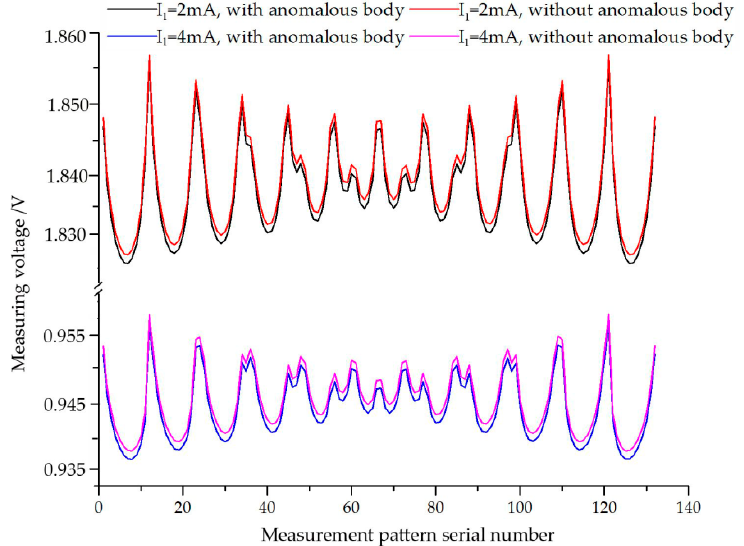
Figure 6. Measuring voltage at di ff erent guard currents when there is an anomalous body and no anomalous body.